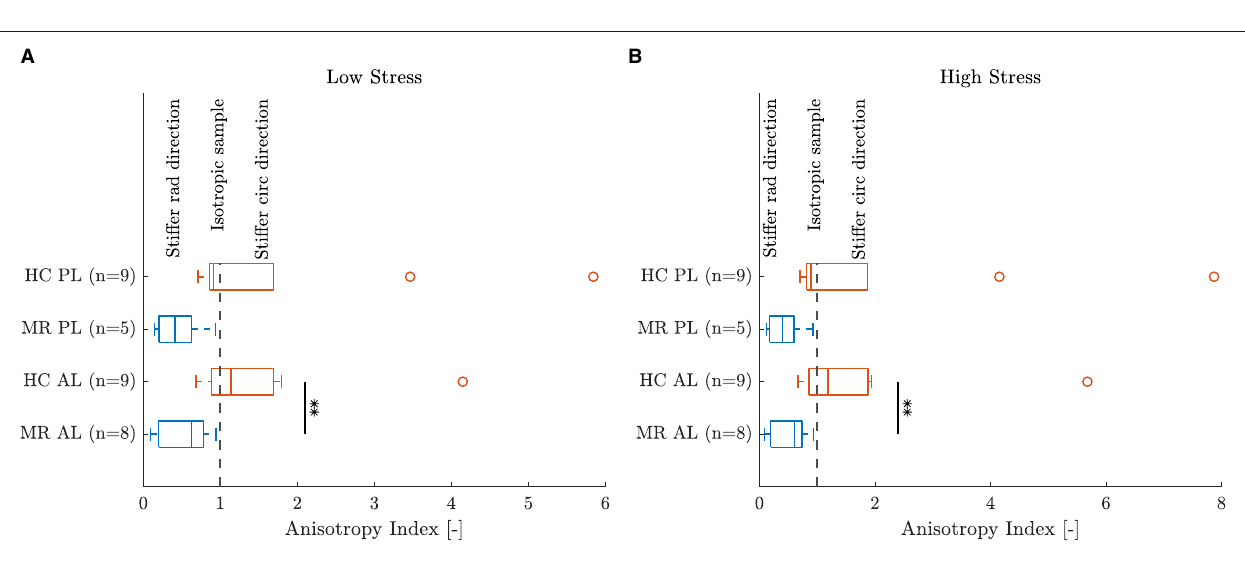
FIGURE 9 | Anisotropy index of the leaflet samples at (A) low and (B) high stress. **Indicates a highly statistically significant difference ( p <